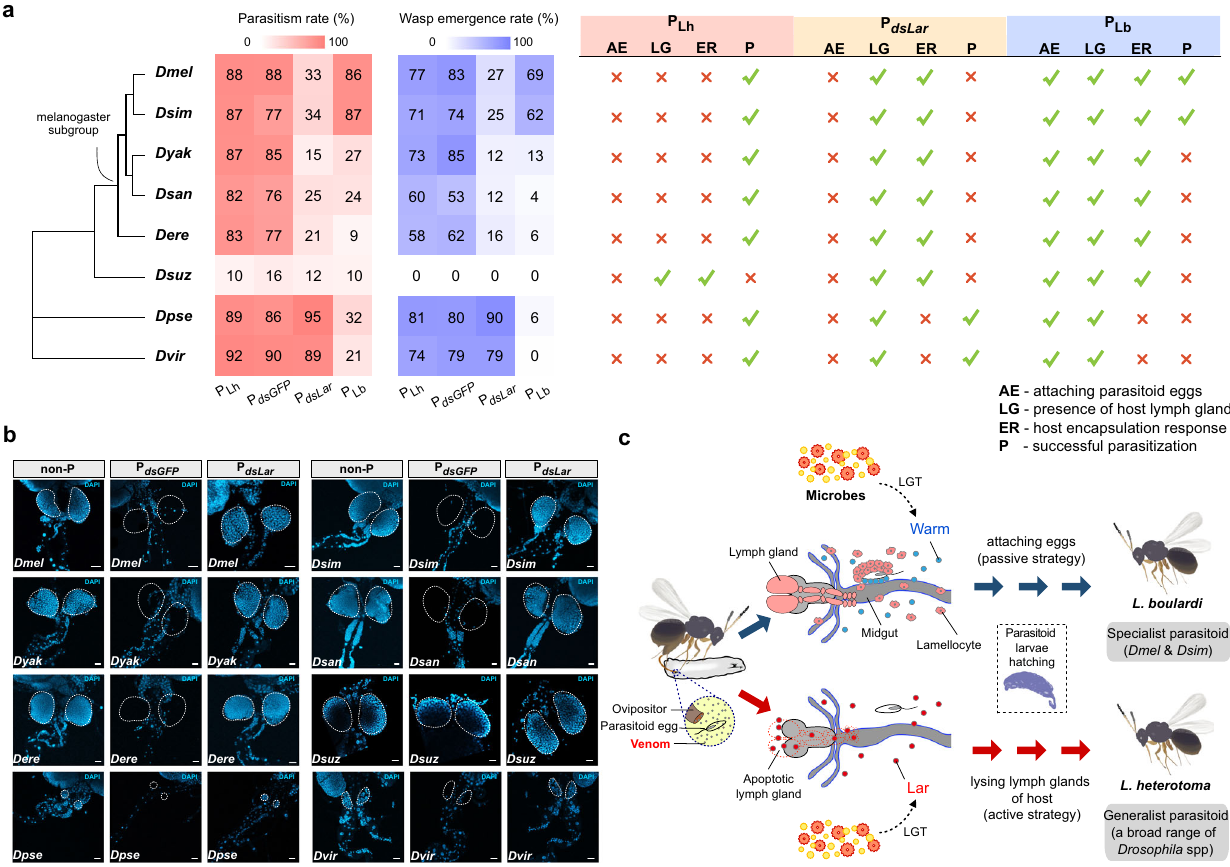
Fig. 5 The adaptive roles of Lar and Warm in driving the shift in host range. a Parasitism rates and wasp emergence rates in eight Drosophila species parasitized by L. heterotoma (P Lh ), dsGFP -treated L. heterotoma (P dsGFP ), dsLar -treated L. heterotoma (P dsLar ), and L. boulardi (P Lb ). The fate of attaching wasp eggs, the presence of host lymph gland 24-h post-infection, and the encapsulation of wasp eggs were also shown on the right. The green checkmark represents present or yes, and the red X represents absent or no. b Lymph glands of nonparasitized Drosophila species (non-P) and of the host larvae that were parasitized by L. heterotoma (P Lh ) and dsLar -treated L. heterotoma (P dsLar ) ( n = 3 replicates, at least 50 lymph glands were examined for each individual). The nuclei were labeled with DAPI (blue). Dashed lines mark the outline of the lymph glands. Scale bars: 20 µ m. c The proposed model of how Leptopilina wasps have evolved diverse parasitic strategies to combat with their Drosophila hosts, leading to a specialist parasitoid (Lb) and a generalist parasitoid (Lh). Dmel D. melanogaster , Dsim D. simulans , Dyak D. yakuba , Dsan D. santomea , Dere D. erecta , Dsuz D. suzukii , Dpse D. pseudoobscura , Dvir